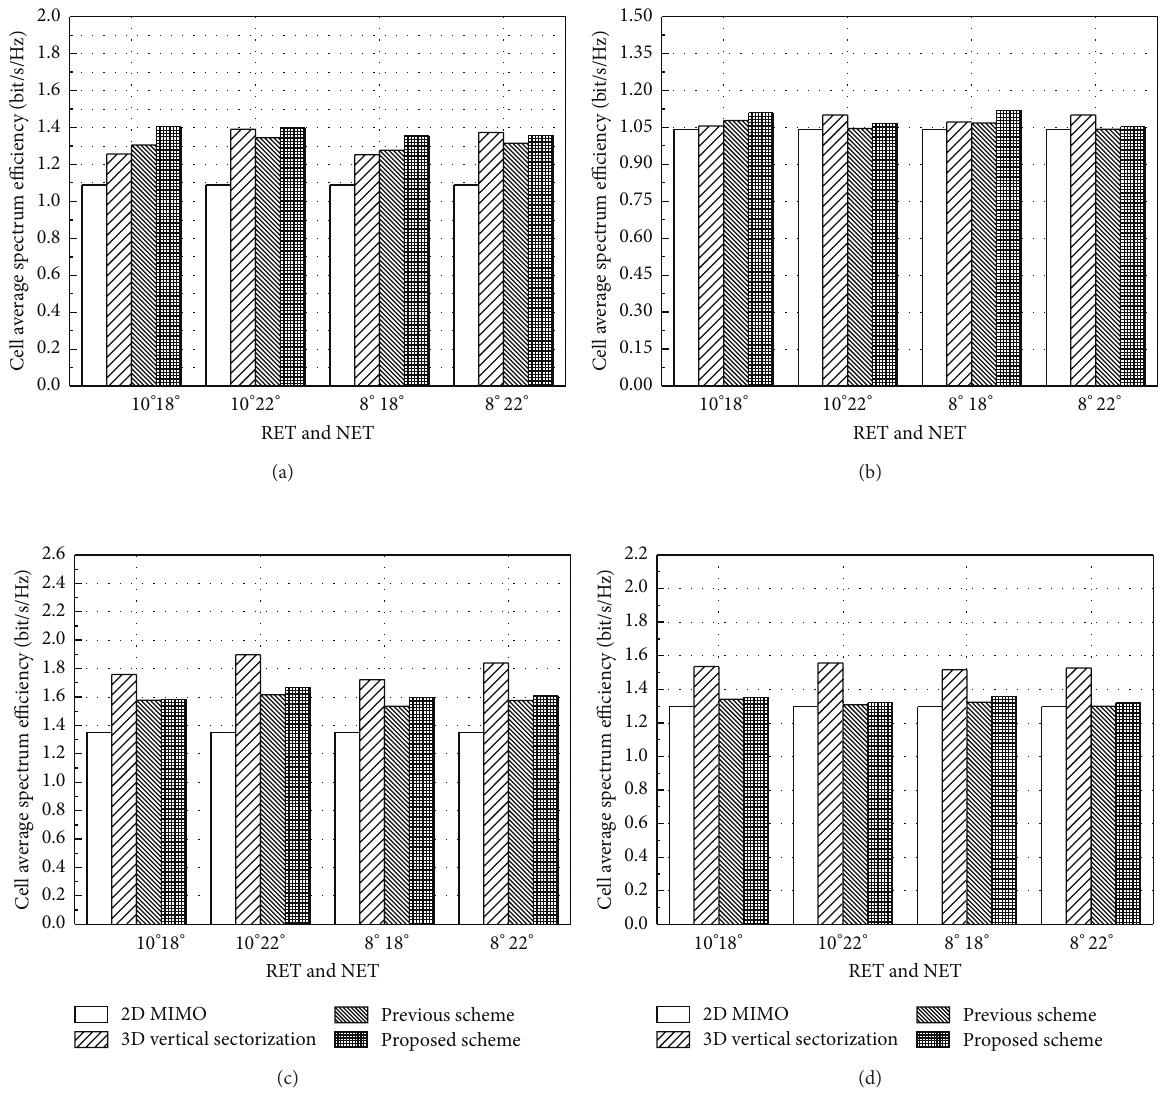
Figure 6: System level results of 2D MIMO, 3D vertical sectorization, previous scheme, and proposed scheme: (a) 2 × 2 cell average spectral efficiency with sector radius of 288 m; (b) 2 × 2 cell average spectral efficiency with sector radius of 288 m; (c) 4 × 2 cell average spectral efficiency with sector radius of 500m; (d) 4 × 2 cell average spectral efficiency with sector radius of 500